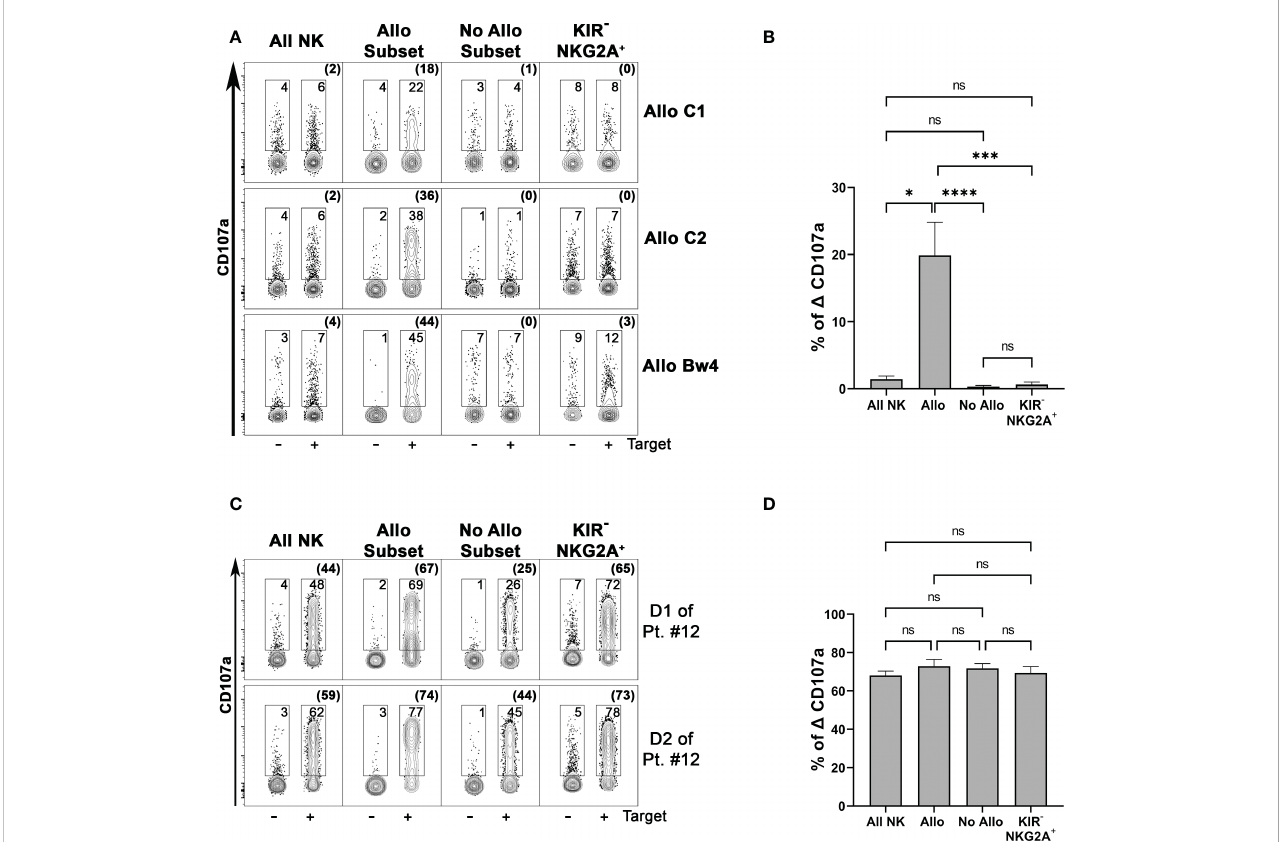
FIGURE 4 The phenotypically identi fi ed donor alloreactive NK cell subsets display the highest degranulation capability against the related patient target cells. (A) Degranulation activity of all NK (CD3 – CD56 + cells) and different NK cell subsets from three donors representative for each type of alloreactivity (D of patient #16, D1 of patient#12, D of patient#14) evaluated upon incubation in the absence or in the presence of PHA-blasts derived from the related patients (Target). Allo Subset consists of NK cells expressing only the iKIR speci fi c for the KIR-L that is missing in target cells, No Allo Subset represents NK cells expressing iKIRs speci fi c for KIR-L on target cells, and KIR − NKG2A + represents NK cells expressing only NKG2A and no KIRs. E:T ratio 2:1. Numbers indicate the percentage of surface CD107a + cells, and the percentages of D CD107 are indicated in brackets. The samples of each donor were concatenated (data aggregated into one fi le) and analyzed using Flowjo. (B) Cumulative data of speci fi c NK cell degranulation activity ( D CD107a) from different donors after stimulation with patient-derived PHA-blasts. Different NK cell subsets were considered. E:T ratio 2:1. n =9 (Allo C1 = 2, Allo C2 = 2, Allo Bw4 = 5). Not signi fi cant (ns), * p < 0.05, *** p < 0.001, and **** p < 0.0001 (Kruskal-Wallis followed by Dunn ’ s multiple comparison test). Mean + SEM are reported. (C) Degranulation activity of different NK cell subsets from two representative Allo C2 donors was tested upon incubation in the absence